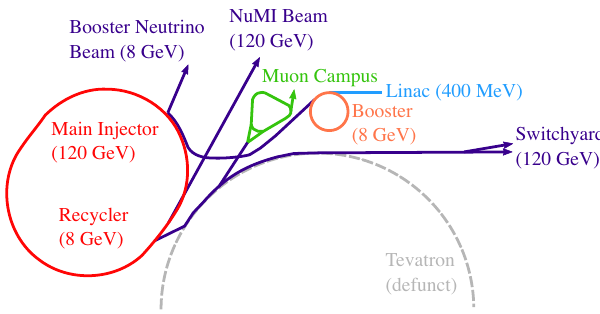
FIG. 1. The Fermilab accelerator complex. H − are produced at the ion source and accelerated to 400 MeV in a normal conducting linac. These H − are stripped to protons upon entry into the Booster where they are accelerated to 8 GeV. Twelve Booster batches are then injected into the Recycler where they are slip-stacked to form six double intensity batches. These batches are then accelerated to 120 GeV in the Main